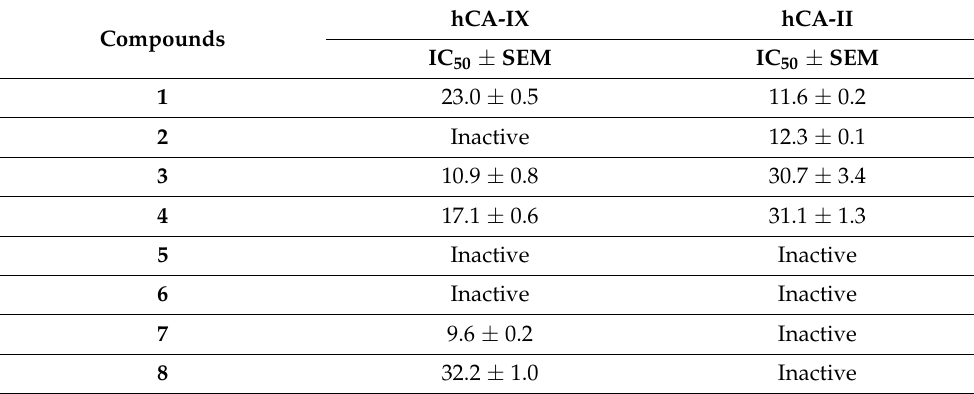
Table 1. In vitro results of compounds against hCA-II and hCA-IX. Compounds